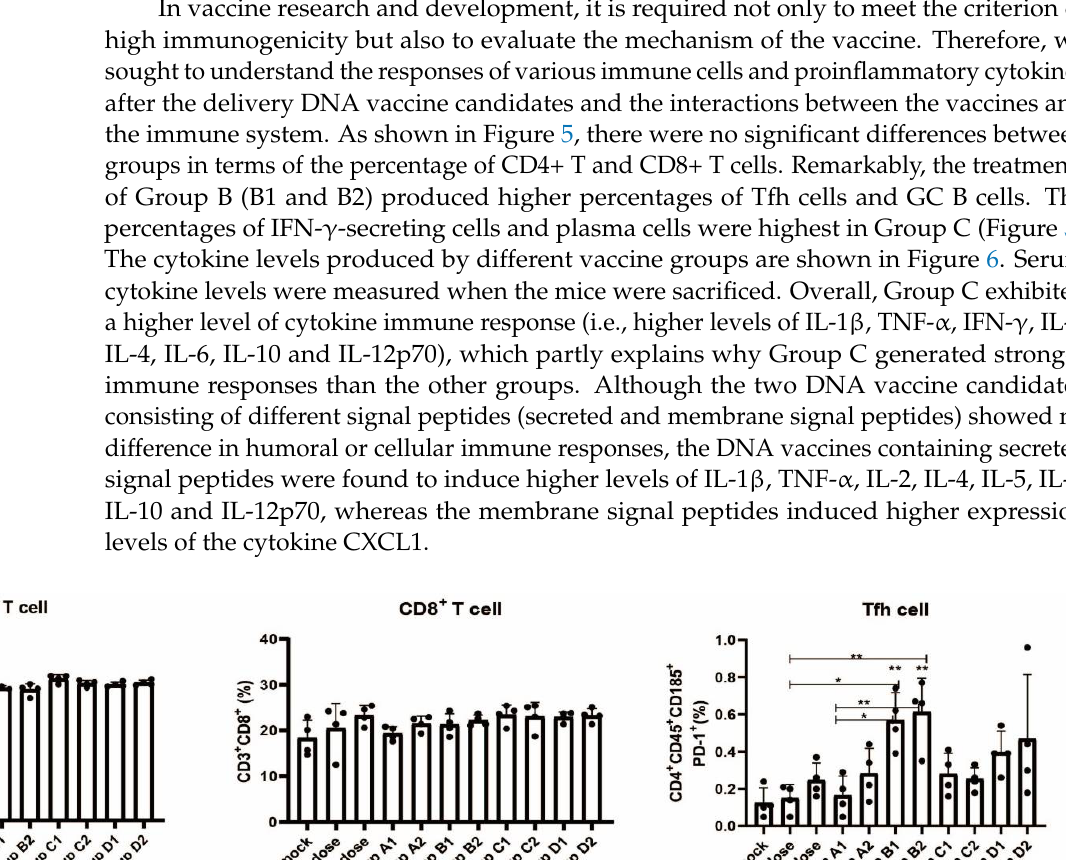
Figure 6. Proinflammatory cytokine analysis of serum samples collected from mice at the time of sacrificing after completion of the immunization procedure. ( A ) IL-1β, ( B ) TNF-α, ( C ) IFN-γ, ( D ) IL- 2, ( E ) IL-4, ( F ) IL-5, ( G ) IL-6, ( H ) IL-10, ( I ) CXCL1, and ( J ) IL-12p70. 1 dose: 1 dose inactivated vaccine control group; 2 dose: 2 doses inactivated vaccine control group; one-way ANOVA (and nonpara- metric or mixed) was conducted; * p < 0.05; ** p < 0.01; *** p < 0.001; **** p < 0.0001 versus the control group.